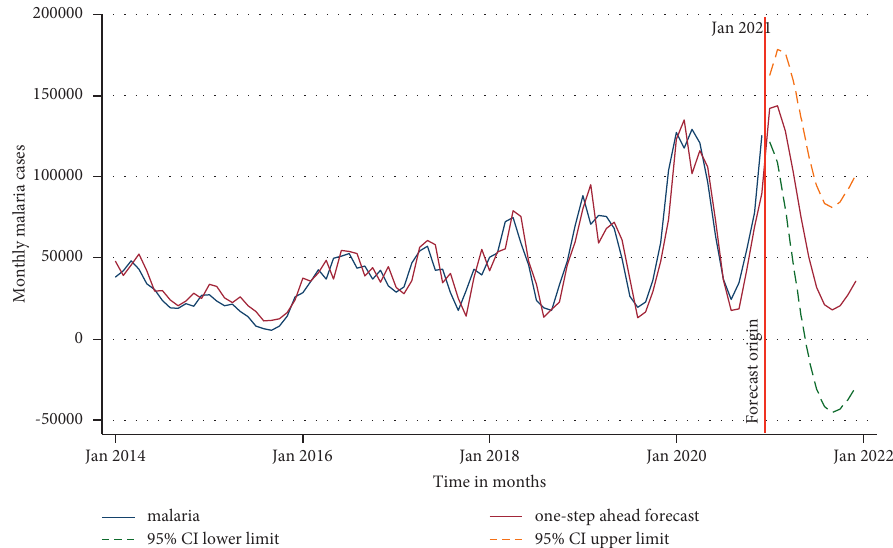
Figure 5: The observed and forecast values for malaria in all ages of the northwestern province from the fitted ARIMA (2, 1, 2) (0, 1, 1) 12 model with their corresponding 95% confidence